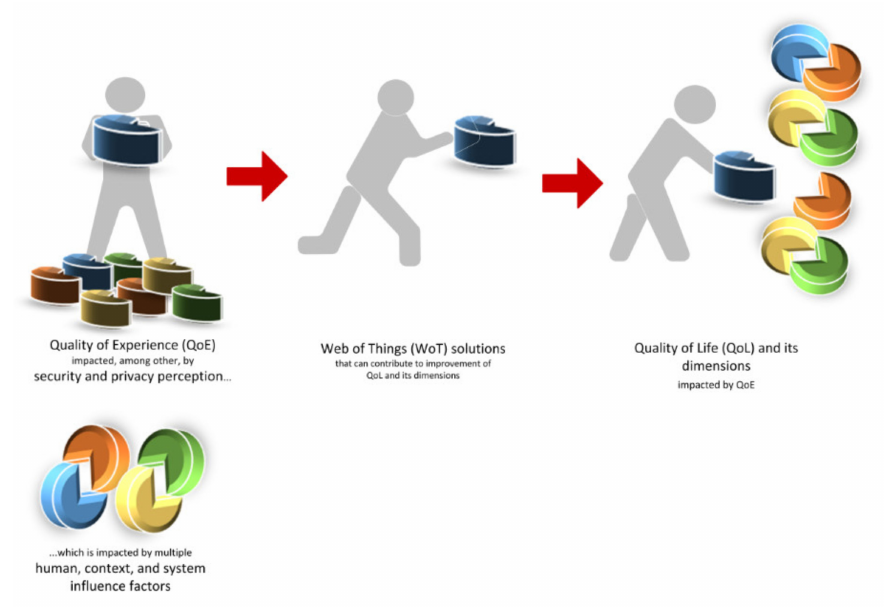
Figure 4. Research steps for